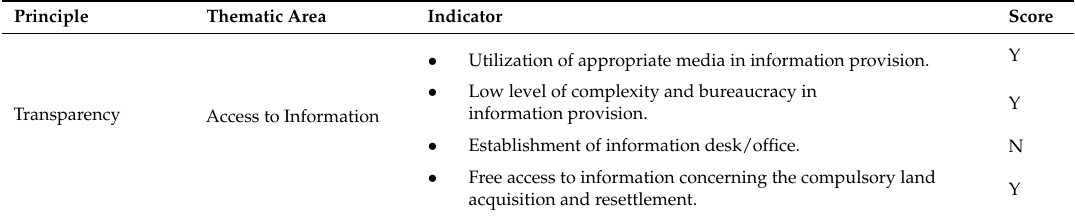
Table A1. Results of Good Governance Assessment in the Bui Dam